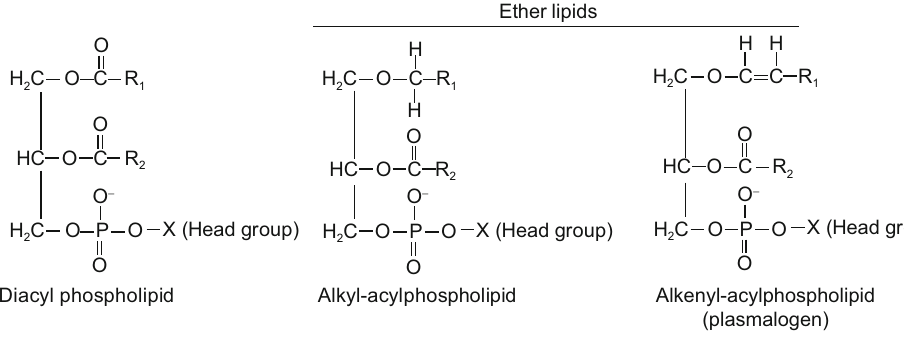
Figure 1. Chemical structures of diacyl and ether-linked phospholipids. Diacyl phospholipids have fatty acyl side chains linked to the sn-1 and sn-2 position of the glycerol backbone by ester bonds. Ether-linked phospholipids are a subclass of glycerophospholipids that have an alkyl chain attached by an ether bond at the sn-1 position. The sn-2 position of ether lipids generally has an ester-linked acyl chain, as in diacyl phospholipids. Some ether-linked phospholipids, called alkenyl-acylphospho- lipids, contain a cis double bond adjacent to the ether linkage and are commonly referred to as plasmalogens. The polar head group of ether-linked phospholipids is most commonly choline or ethanolamine.